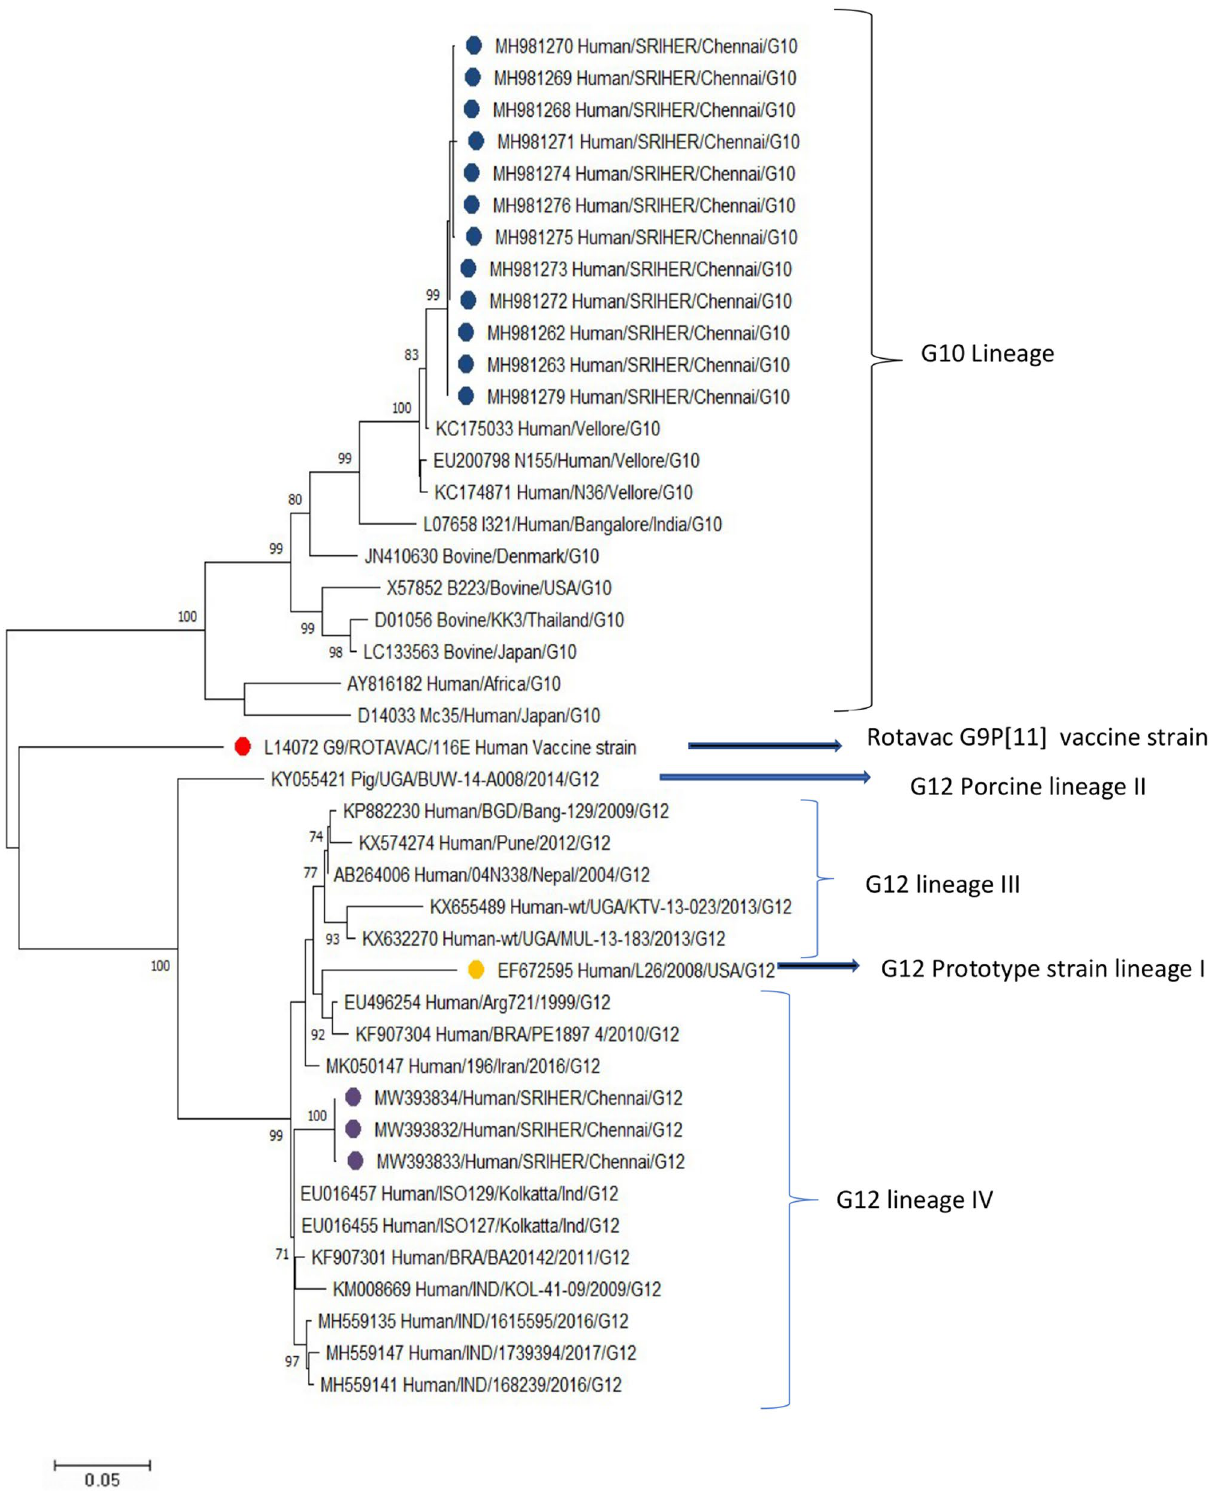
Figure 2. Molecular phylogenetic analysis by maximum likelihood method. Phylogenetic analysis of VP7 gene of G12 and G10 RV strains. The study strains G12 are indicated in purple circle, and G10 study strains are shown in blue circle. The phylogenetic tree was constructed using the Maximum Likelihood method and Kimura 2-parameter model using MEGA-X. Bootstrap values (1000 replicates) less than 70% are not shown. Scale bar indicates the evolutionary distance (nucleotide substitution per